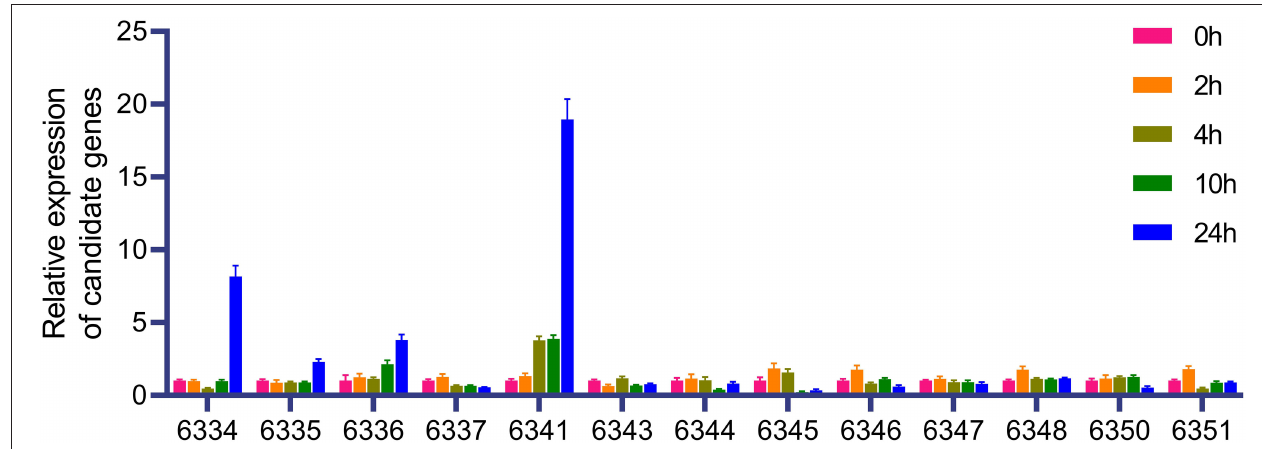
FIGURE 6 | Expression of candidate gene under XY-1 treatment. The last four numbers of the gene number are used to represent the corresponding gene. Complete gene numbers are shown in Supplementary Table S6